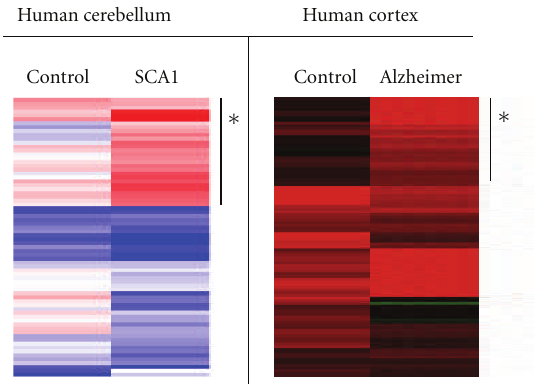
Figure 2: Activation of miRNA expression in the a ff ected brain compartments of Alzheimer’s and SCA1 patients. The asterisks indicate the subsets of miRNAs and ncRNAs that are specifically upregulated in SCA1 cerebellum and Alzheimer’s